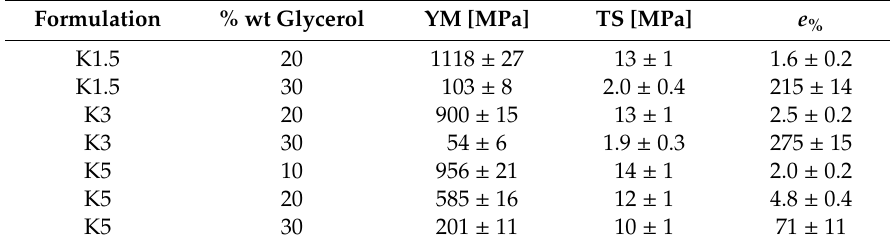
Table 2. Tensile parameters YM, TS, and e % obtained for water kefir films formulations K1.5, K3, and K5. Values are an average from ten replications experiments for each specimen ( p < 0.05).